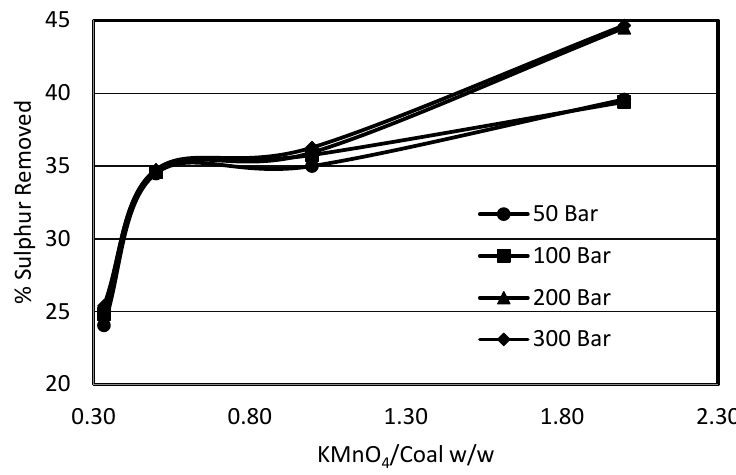
Figure 3. Effect of KMnO 4 /Coal ratio on organic sulphur removal.